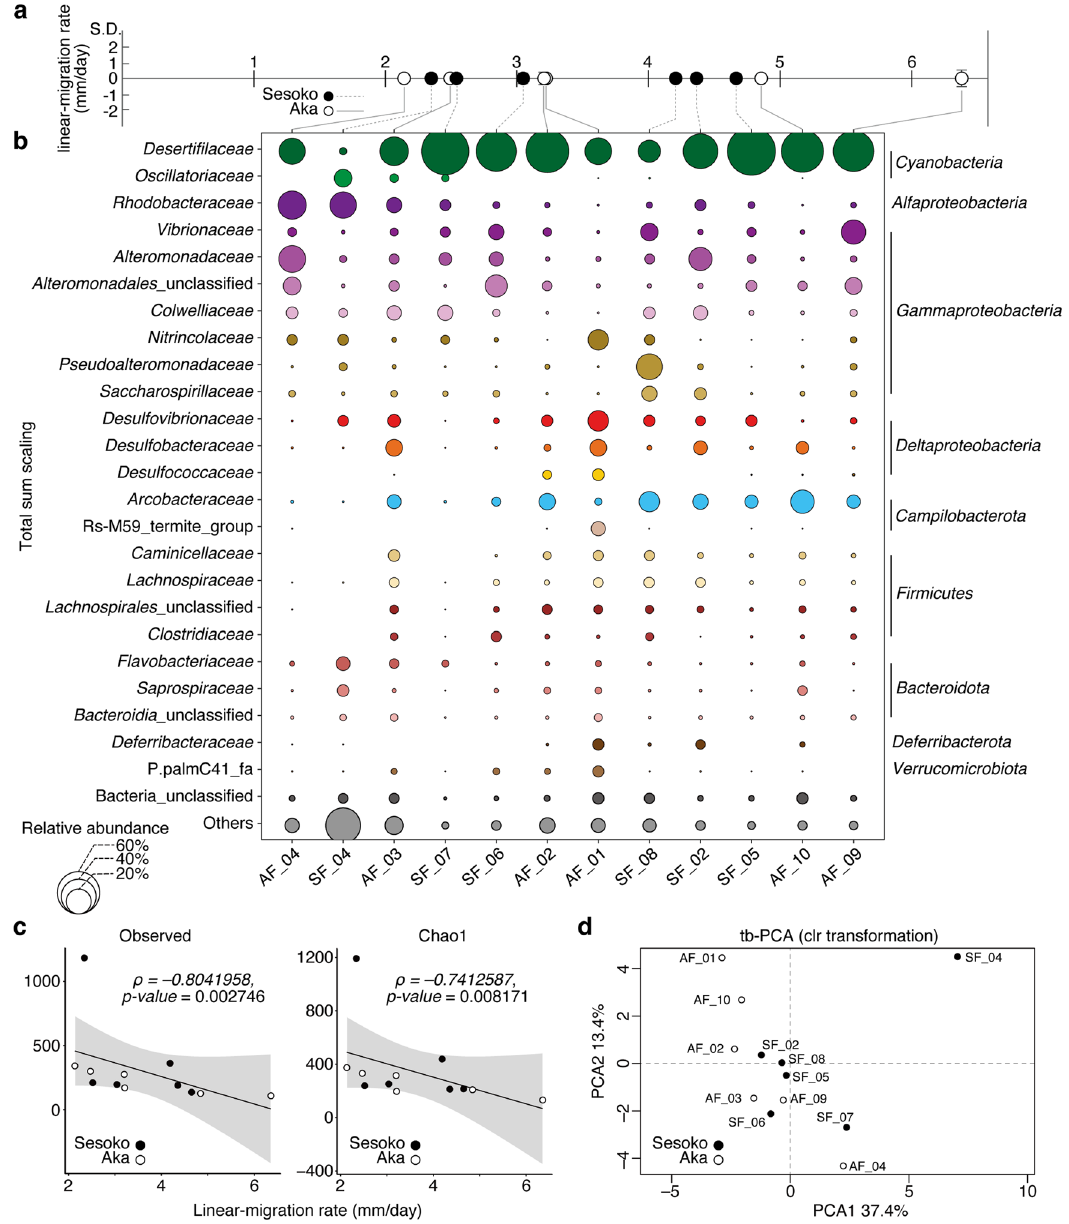
Fig. 3 Relative abundance of bacterial communities, alpha-, and beta-diversities in BBD microbial mats showing different migration rates. Along various migration rates of BBD from two locations ( a ), bubble plots showing the relative bacterial abundance (depicted by size) of the top 24 families, unclassi fi ed bacteria and others (that average <0.5% of that relative abundance were pooled) at total sum scaling ( b ). Signi fi cant correlations between migration rates and alpha diversities (OTU richness and Chao1 index) from BBD calculated by Spearman ’ s rank correlation at total sum scaling ( c ). Grey shading shows 95% con fi dence intervals for the Spearman rank correlation ( c ). A clr-transformed- based principal component analysis (tb-PCA) representing the bacterial communities (family level) in BBD ( d ). Sample IDs indicated as ‘ AF ’ and ‘ SF ’ were collected from Aka Island and Sesoko Island,